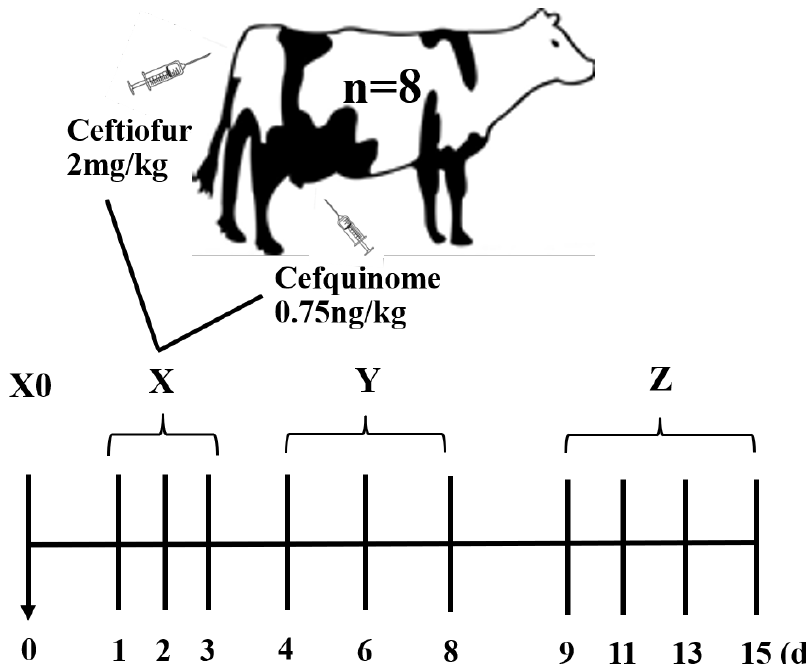
Figure 5. Timeline for fecal sampling. Sampling days are displayed above the black lines. The antibiotic treatments are noted at Days 1, 2, and 3. X0, X, Y, and Z indicate the periods Day 0, medication, withdrawal, and recovery, respectively.